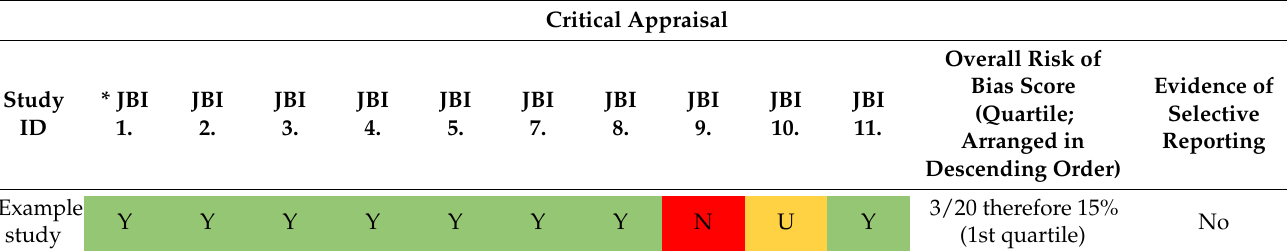
Table 1. Example of critical appraisal